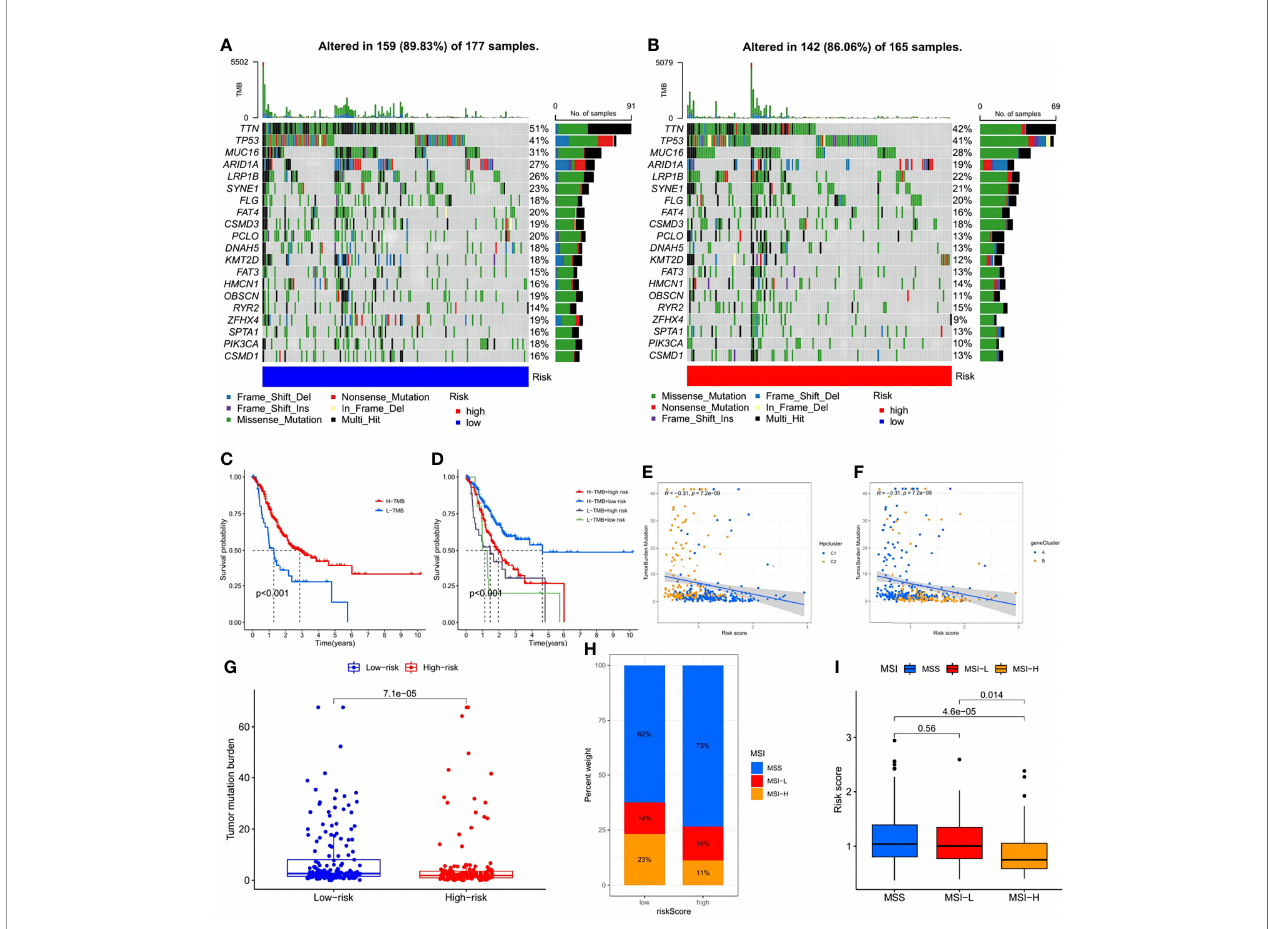
FIGURE 10 | Exploration of the association between the tumor somatic mutation, MSI and risk signature. (A, B) The waterfall plots of tumor somatic mutation constructed by those with low- and high-risk scores, respectively. (C) Survival analysis on STAD samples with high and low TMB. (D) Survival analysis on STAD samples with different TMB and risk score. (E, F) Relationships between TMB and risk score based on HPclusters and gene clusters, respectively. (G) Distribution of STAD samples with low- and high-risk score in TMB. (H, I) Relationships between risk signature and